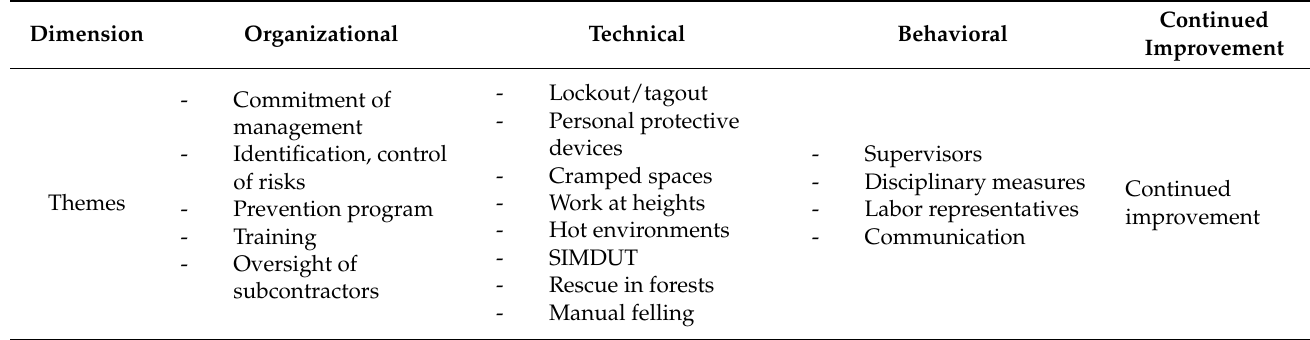
Table 12. Structure of the “Profil SST” tool [7].